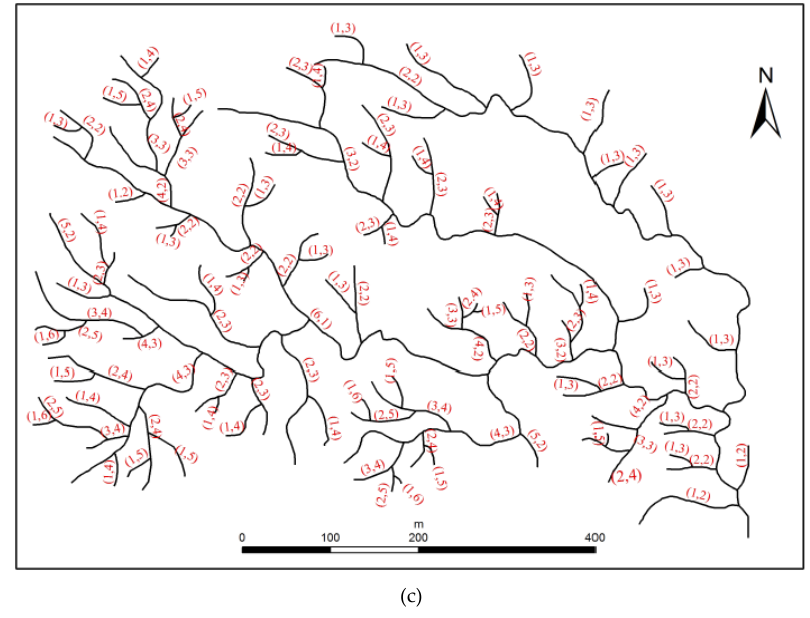
Figure 9. Comparison of the stream coding systems: ( a ) top-down coding method, ( b ) bottom-up coding method and ( c ) hybrid coding method.